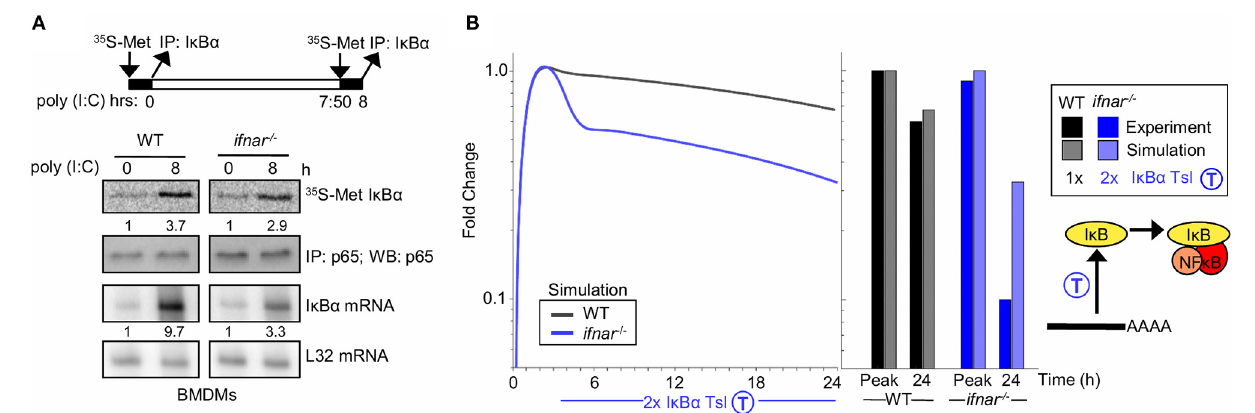
FIGURE 3 | Type I interferon signaling potentiates late NF κ B activity by translational inhibition of I κ B α (A) Experiments to determine I κ B α translation rate in BMDMs. Top, schematic of the experimental design: 35 S-labeled Methionine pulsed at 0h and following 8h of Poly(I:C) stimulus. Middle, immunoprecipitates of I κ B α following a 35 S-methionine pulse at either indicated timepoint. NFkB p65 immunoprecipitates are shown as normalization controls. Bottom, I κ B α mRNA analysis using RNA protection assay. Ribosomal protein gene L32 is provided as a control. These data are representative of three biological replicates. Quantitations are relative to